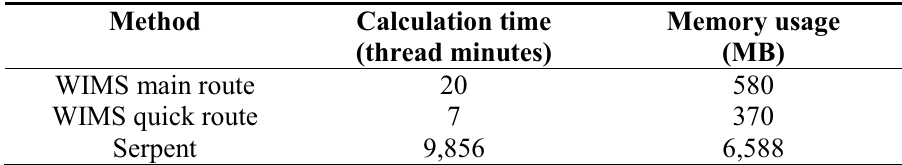
Table 1: Indicate computational cost for the two WIMS routes